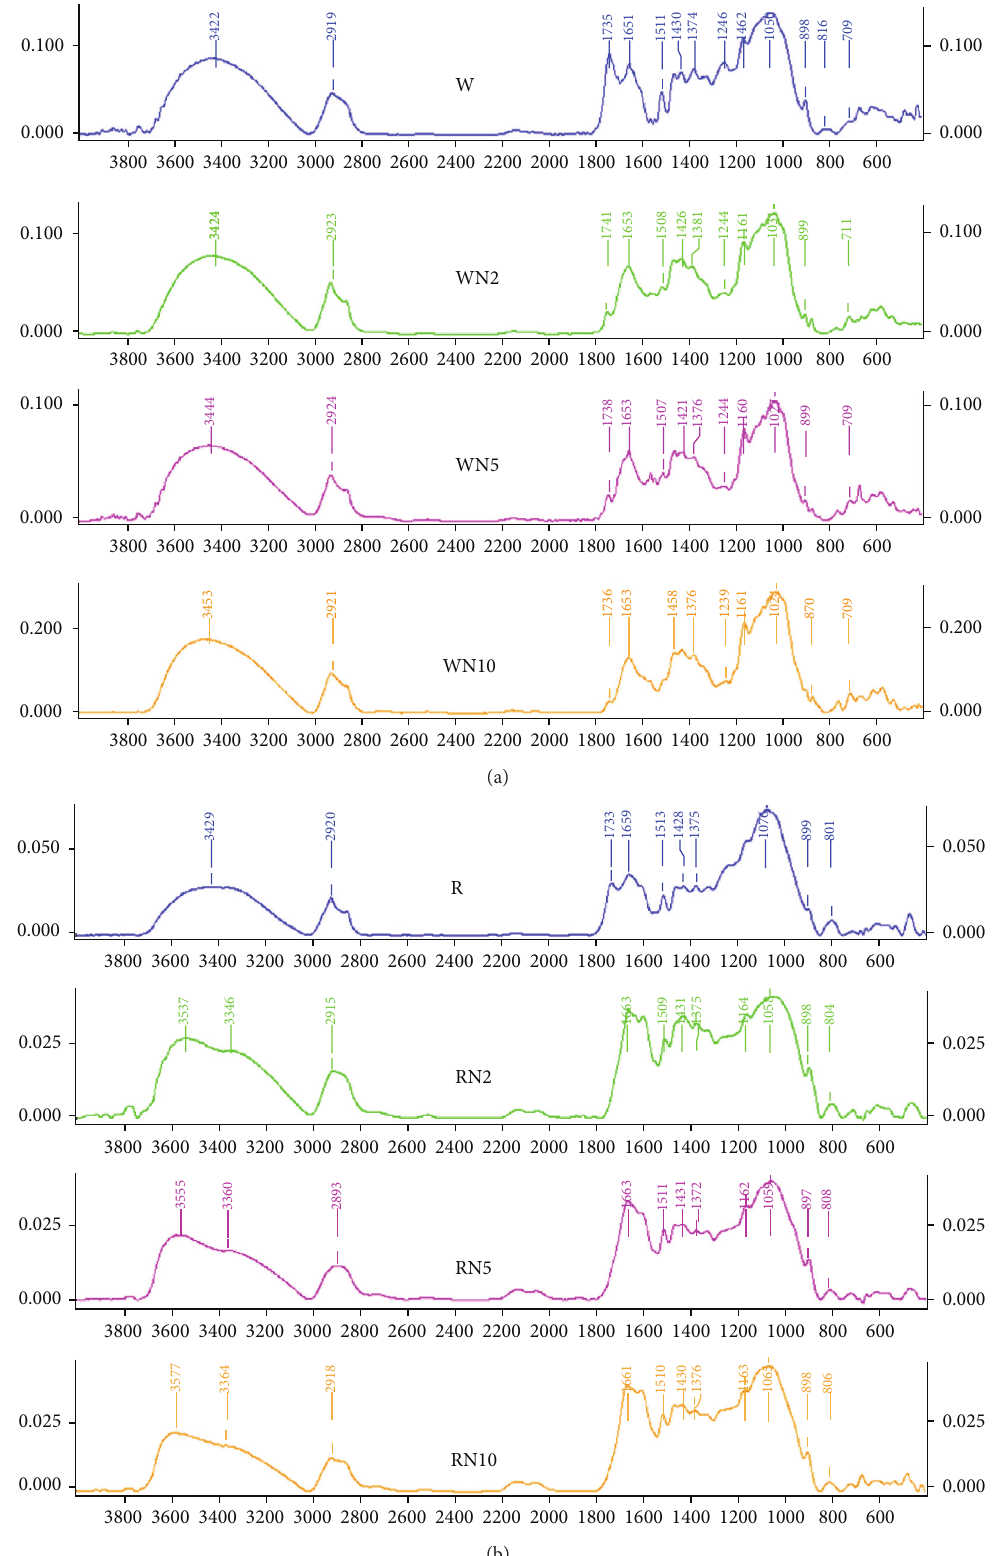
Figure 14: FTIR spectra of untreated and alkaline treated (a) wheat husk and (b) RH at different NaOH concentrations (2, 5, and 10%). Einkorn wheat husk (W), einkorn wheat husk + NaOH (WN), long-grain RH (R), and long-grain RH + NaOH (RN)